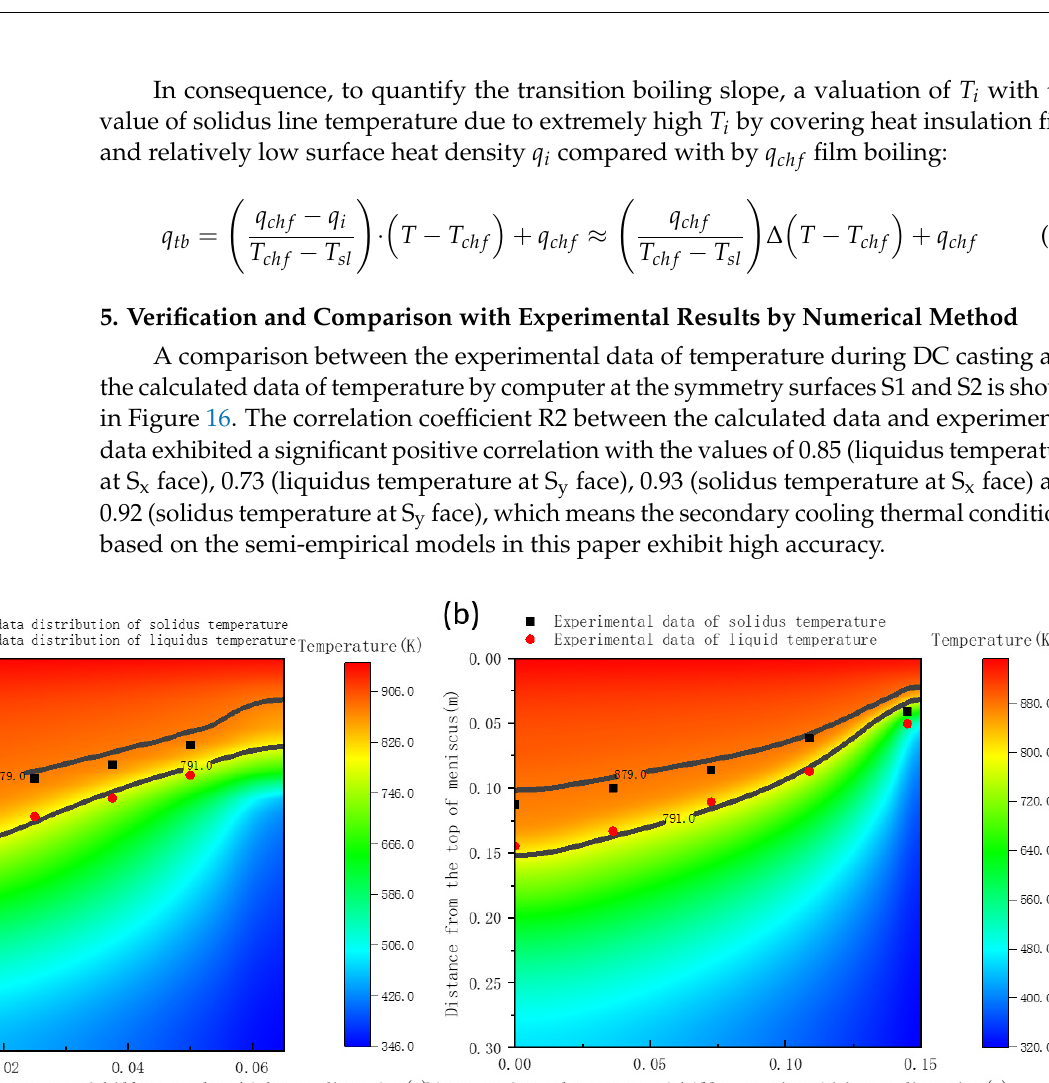
Table 3. The value of 𝑇 (cid:3030)(cid:3035)(cid:3033) during DC casting temperature-measurement test.